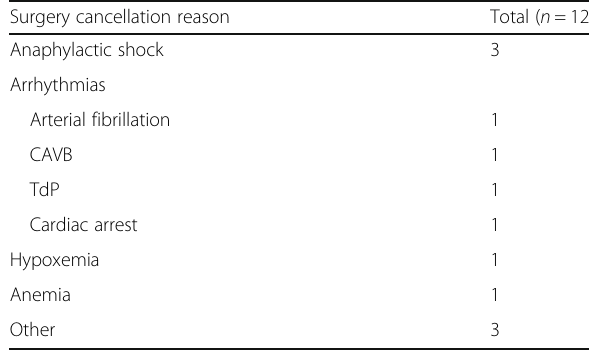
Table 4 Cases surgery cancelled after anesthesia and cause of